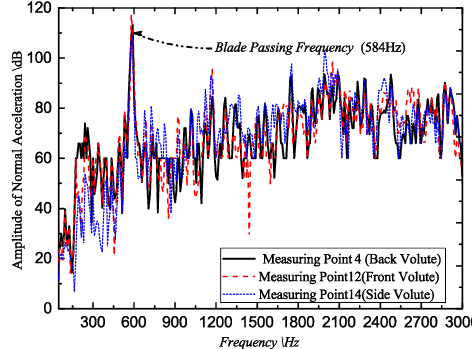
Figure 12. The spectrum of acceleration on the three different measuring points.